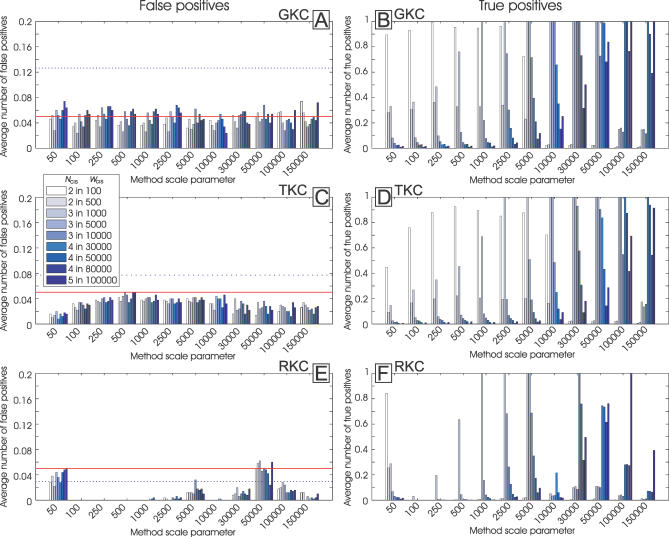
Results from Simulation Experiments—True and False Positives(A,B) Results for the GKC applied to artificial data.(C,D) Results for the TKC.(E,F) Results for the RKC.The horizontal solid lines in (A), (C), and (E) show the 5% significance level, the dotted lines show the average number of csFPs. The legend shows the different simulated CISs, stating the number of insertions N
CIS that fall within the CIS of width W
CIS.